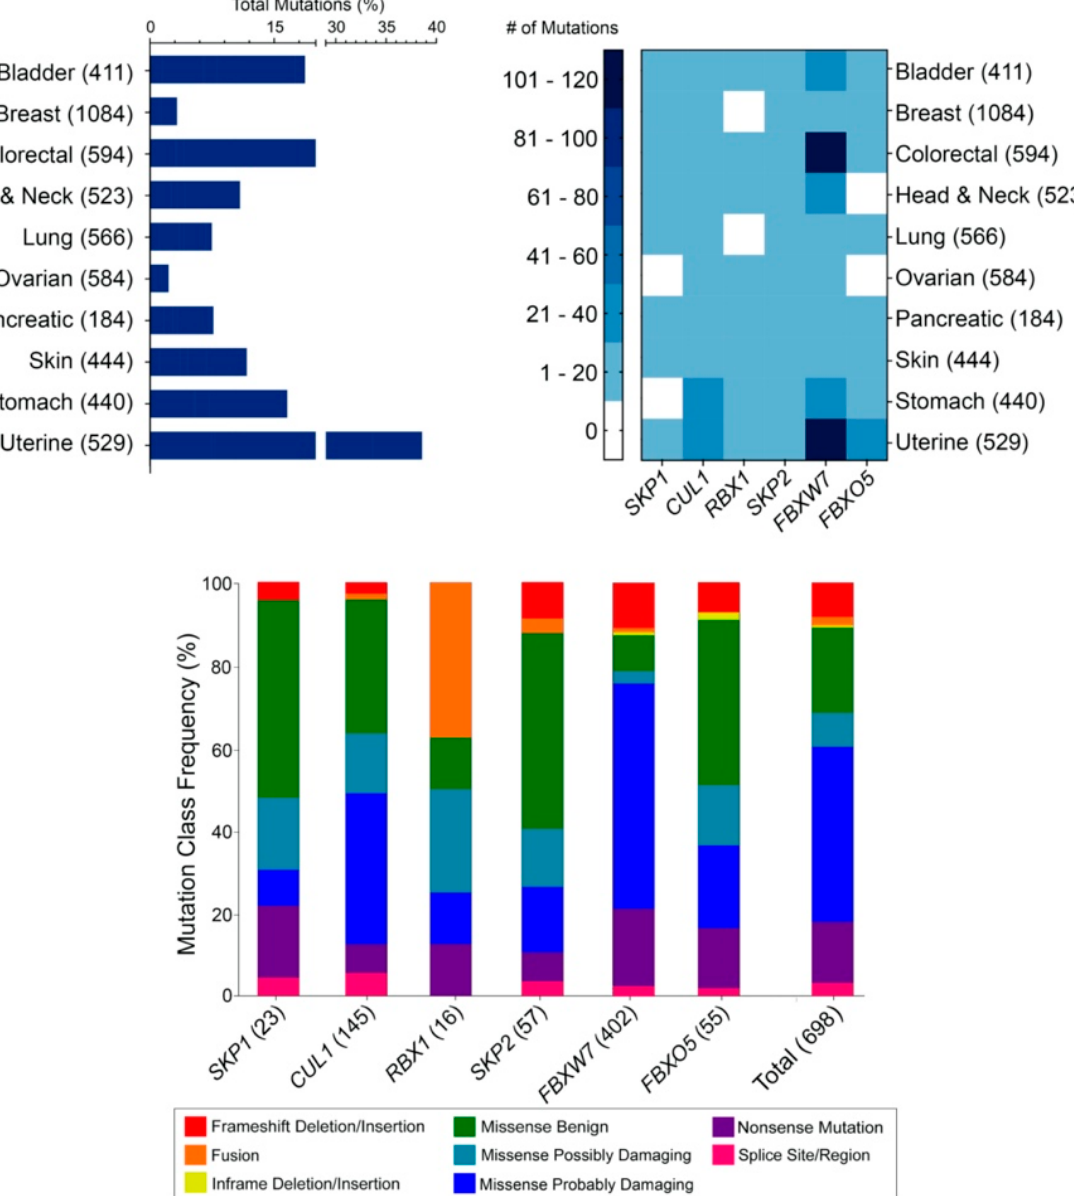
Figure 1. Frequency and types of mutations of six SCF complex member genes in 10 cancer types. ( A ) Bar graph (left) and heatmap (right) displaying the frequency and prevalence, respectively, of SCF complex member gene mutations in 10 cancer types with the total number of cancer cases indicated within brackets. Alteration categories include frameshifts, fusions, in-frame deletions/insertions, missense, nonsense and splice site mutations. ( B ) Bar graph presenting the frequency of the alteration categories from 10 cancer types, with the aggregate total frequencies provided in the last column (Total). The total number of alterations identified for each gene are indicated within brackets.